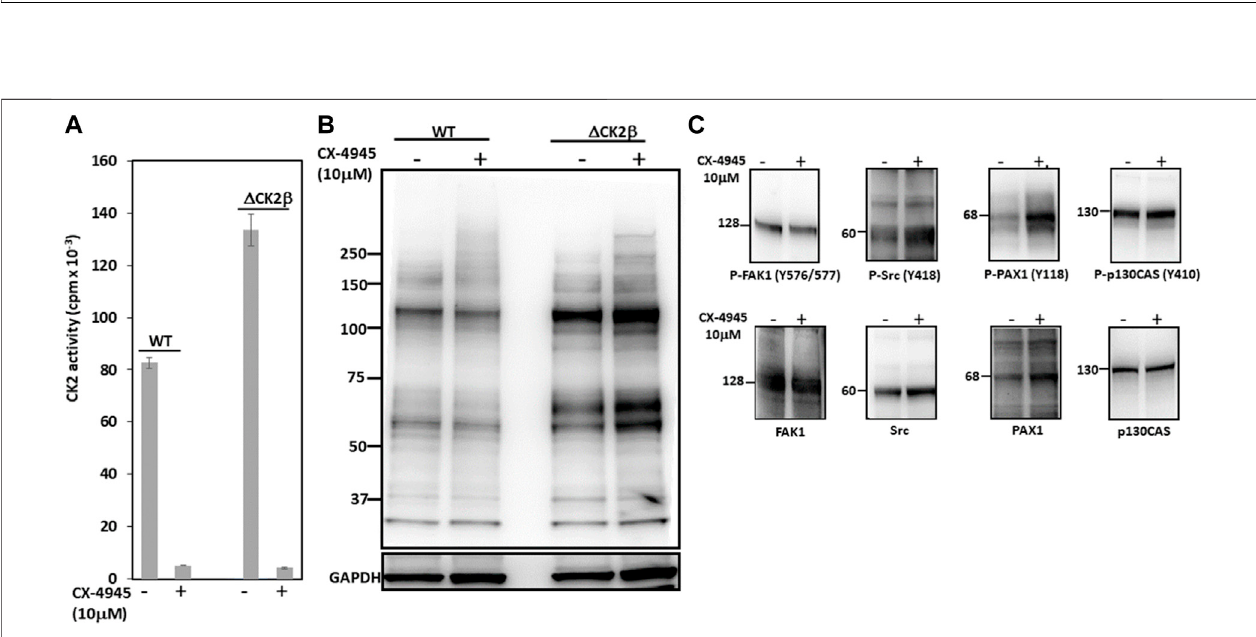
FIGURE 5 | CK2 catalytic activity does not contribute to enhanced Tyr phosphorylation in Δ CK2 β MCF10A cells. (A) CK2 kinase activity in cell lysates from WT or Δ CK2 β MCF10A cellstreatedfor5 hintheabsenceorpresence of10 μ MCX-4945. (B) Celllysates asin (A) wereWesternblottedwith4G10antibodyforthepresence of pTyr proteins. GAPDH was used as a loading control. (C) Δ CK2 β MCF10A cell lysates were also analyzed by Western blotting for p-FAK (Y576/577), p-Src (Y418), p-PAX1 (Y118), p-p130CAS (Y410), FAK, Src, PAX1, and